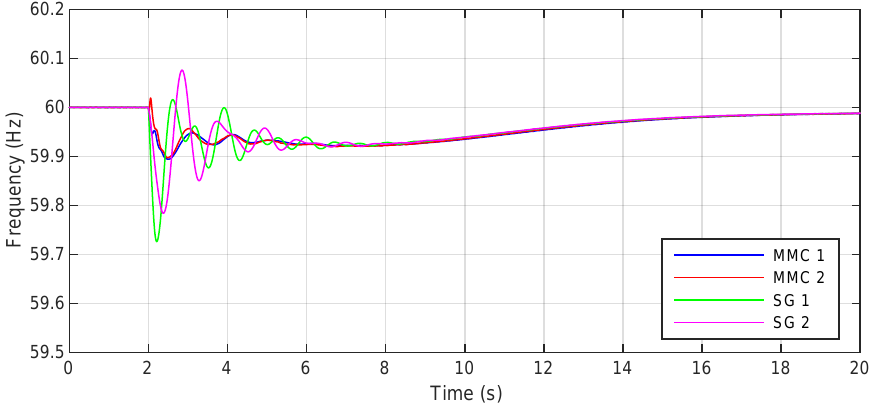
Figure 14. Frequency behavior of the elements of the test system after disturbance in Scenario 3.